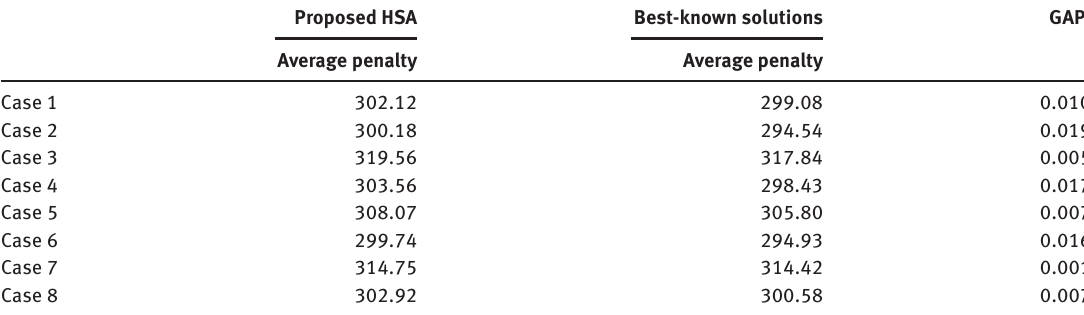
Table 10: Result of 5000 Iterations Obtained with Proposed Parallel HSA.